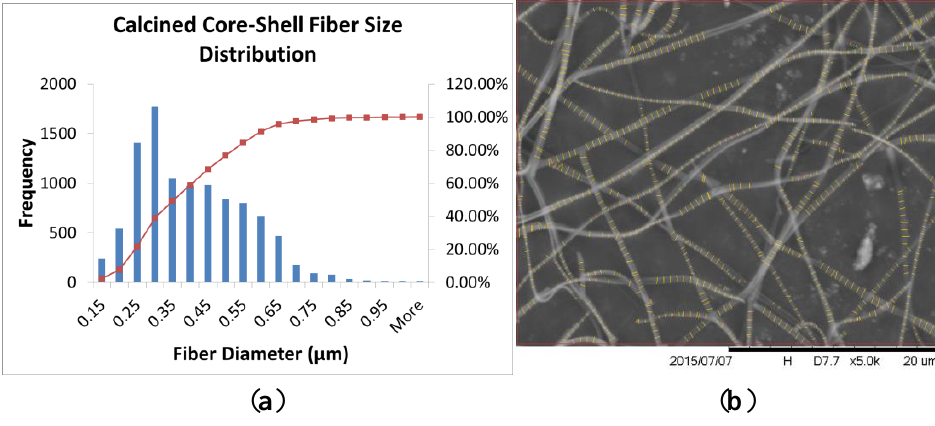
Figure 6. ( a ) Fiber size distribution analysis histograms and ( b ) sample SEM images after FibraQuant™ analysis for the core–shell fibers after calcination at 600 °C for 5